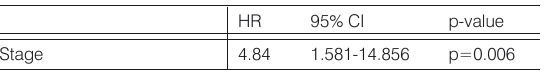
Table 3. Multivariate proportional hazards models of prognosis in patients with breast carcinoma.